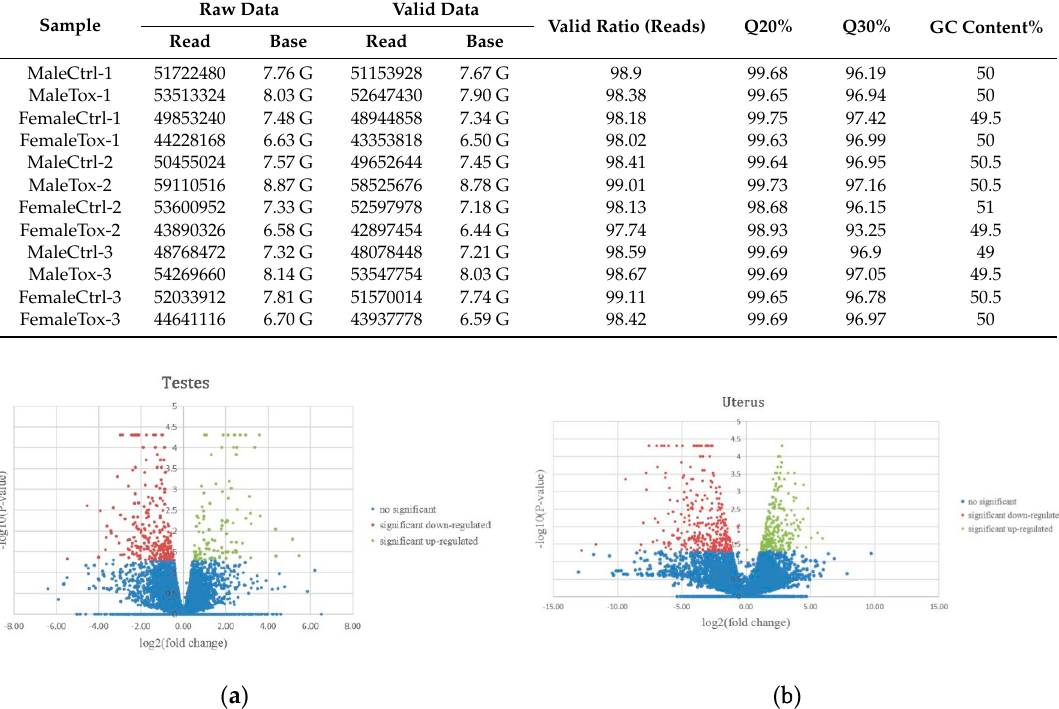
Table 2. Pretreatment results of reads data in the high throughput sequencing.